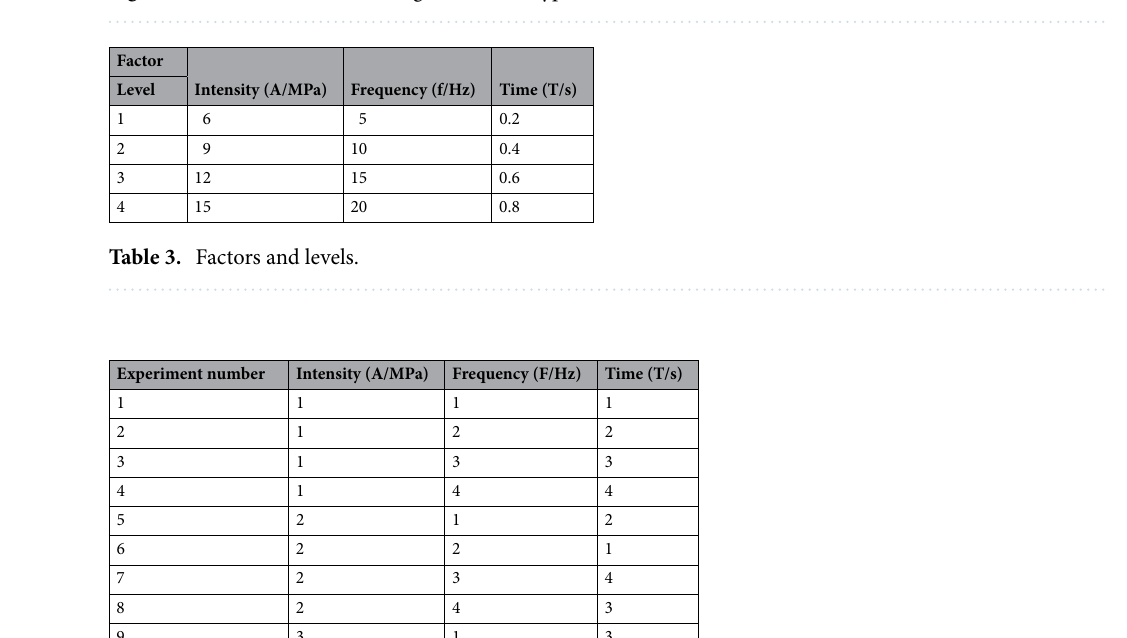
Figure 14. The law of surrounding rock failure types under different disturbance time.